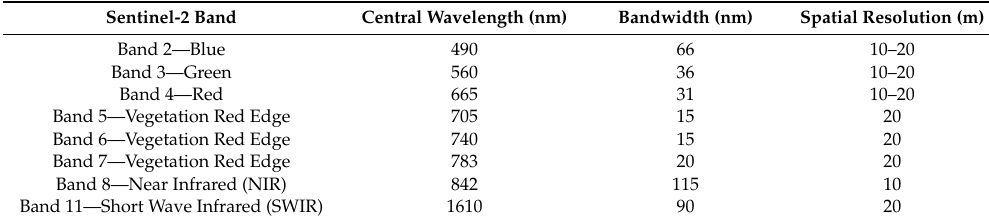
Table 3. Sentinel-2 spectral bands used in this study.